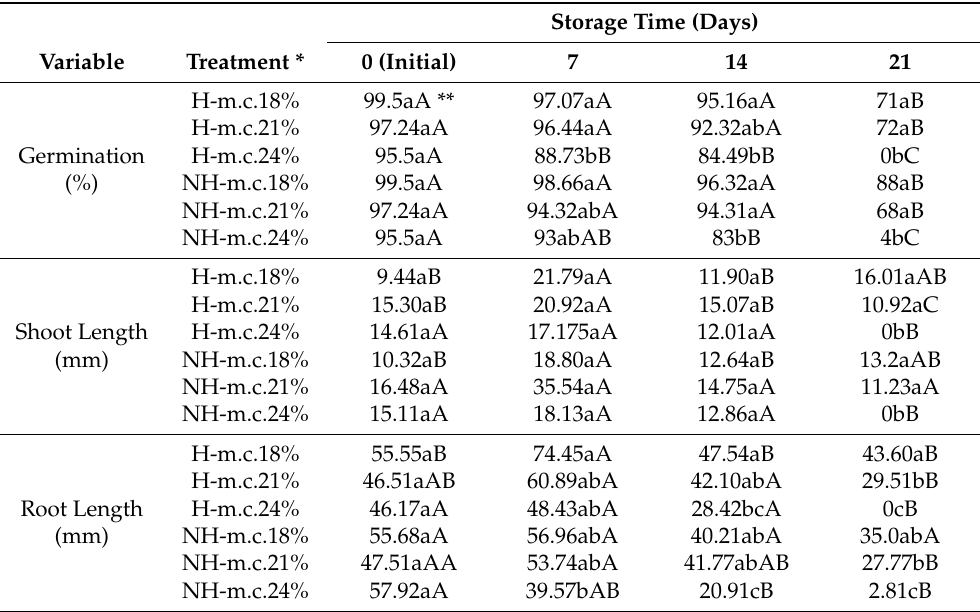
Table 1. Germination (%), shoot length (mm), and root length (mm) of maize at 18, 21, and 24% m.c. stored for up to 21 days in hermetic and non-hermetic jars at 25 ◦ C and 80% relative humidity. Storage Time